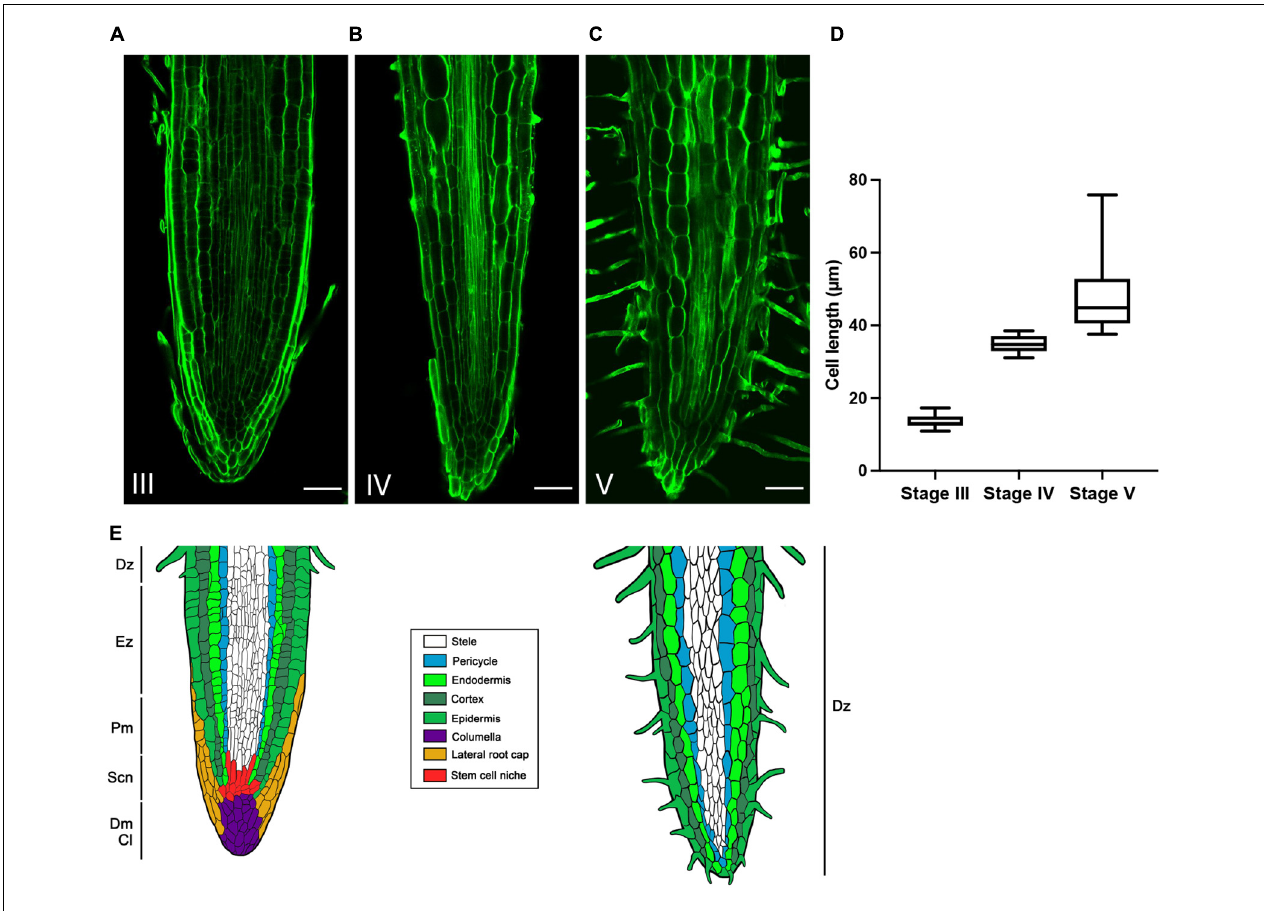
FIGURE 4 | Evolution of cortical cells in the rootlet tips from stage III to V. Calcofluor was used to stain 100- µ m thin longitudinal sections of rootlets. Typical images of rootlet tips at (A) stage III, (B) stage IV, and (C) stage V, are shown. Cell lengths were measured with Cell-o-Tape along 300 µ m following a cortical cell line starting from the organization center (D) Cell lengths of a cortical line from stage III to V ( n = 11). (E) Schematic representation of the evolution of rootlet tip before and after the developmental shift. Dz, differentiation zone; Ez, elongation zone; Pm, proximal meristem; Scn, stem cell niche; Dm, distal meristem; Cl, Columella. Scale bars: (A–C) 50 µ